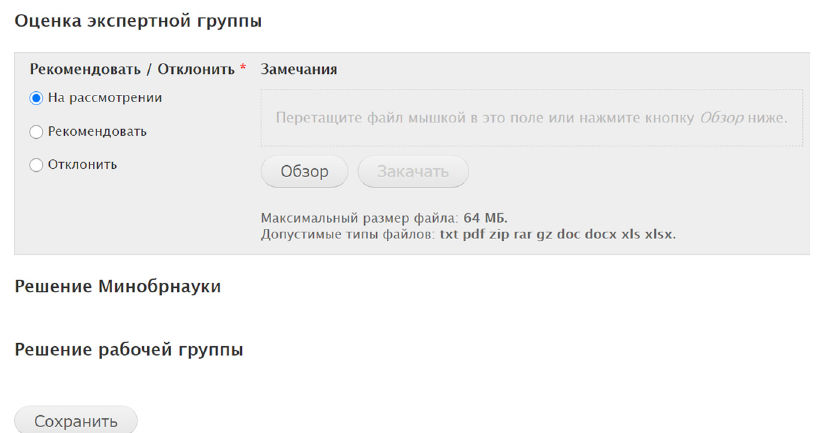
Figure 7: The interface for evaluating an application for financing a collection by a member of an expert group. The possibility of announcement of the decision and attaching the extended review is available. However, the fields for evaluation by the members of the working group and by the Ministry staff are not